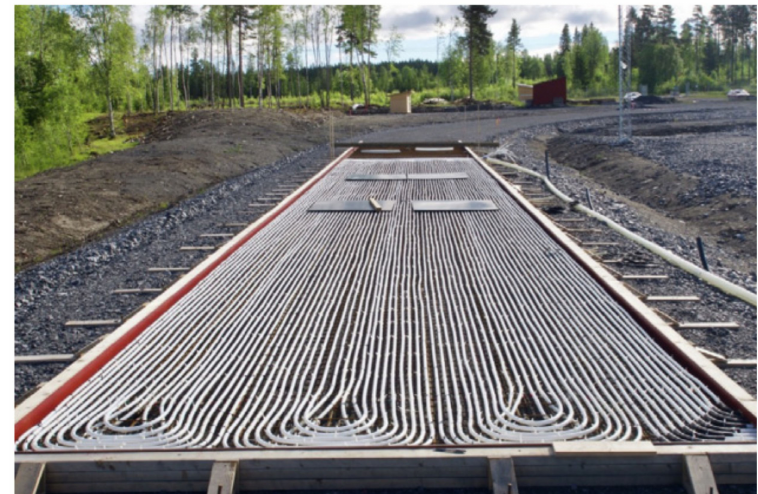
Figure 8. Construction of a solar pavement collector near Östersund, Sweden [74]. Reprinted from Applied Energy, A numerical and experimental study of a pavement solar collector for the northern hemisphere, Josef Johnsson, Bijan Adl-Zarrabi, 260 , 114286, Copyright 2019, with permission from